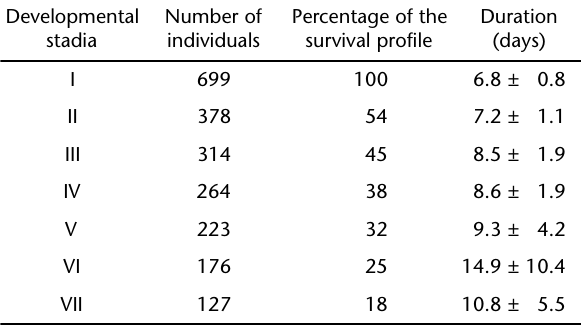
Table I. Number of individuals, percentage of the survival profile and of duration at each developmental stadia of the P. salvator . Developmental Number of Percentage of the stadia individuals survival